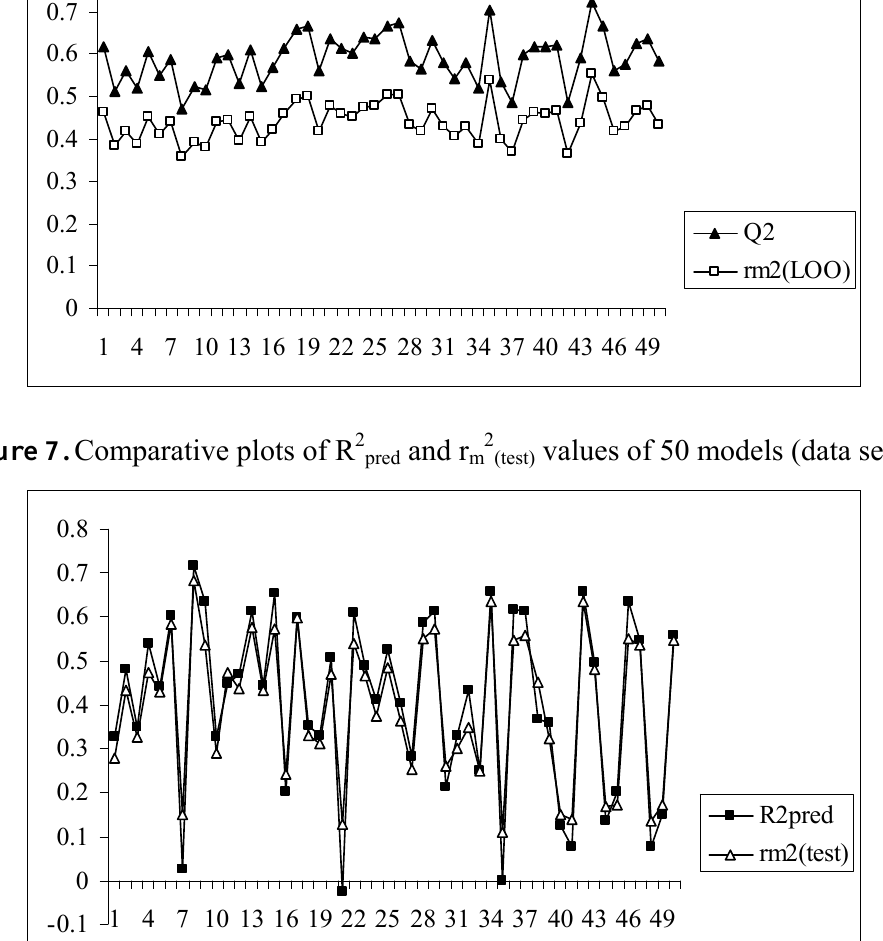
values of 50 models (data set II). (LOO)